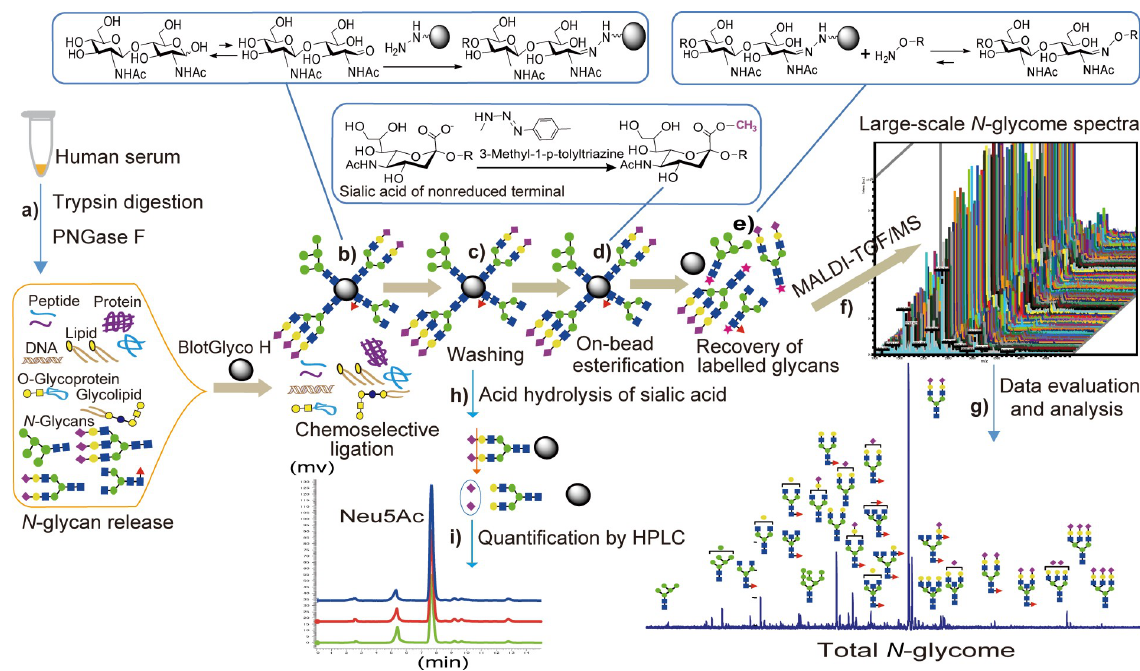
Fig 1. Schematic workflow of glycoblotting-assisted MALDI-TOF/MS and HPLC analysis. ( a ) Enzymatic treatment for serum protein digest and deglycosylation using trypsin and PNGase F, respectively, ( b ) Chemoselective capturing of reducing sugars onto a hydrazide- functionalized BlotGlyco H beads from complex mixture of biomolecules, ( c ) Washing to remove all impurities, ( d ) On-bead methyl esterification of sialic acid residues, ( e ) Recovery of BOA-labeled glycans, ( f ) MALDI-TOF/MS analysis, ( g ) Data processing and evaluation, ( h ) Cleavage of free sialic acid residues from captured N -glycans, ( i ) Free sialic acid labeling and quantification by fluorescence-HPLC.